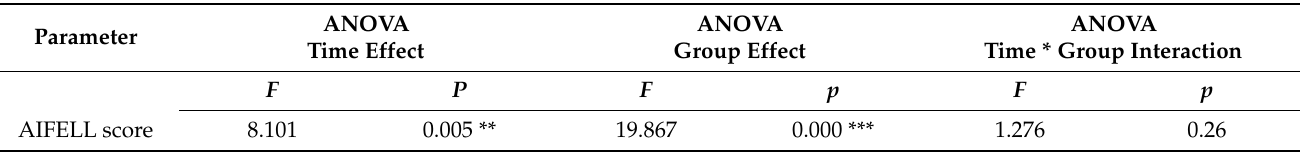
Table 3. Multiple linear regression of COVID-19 maximal stage during hospitalization by AIFELL Table 4. Results of ANOVA with repeated measures comparing AIFELL scores at admission and score. worst disease stage reached during